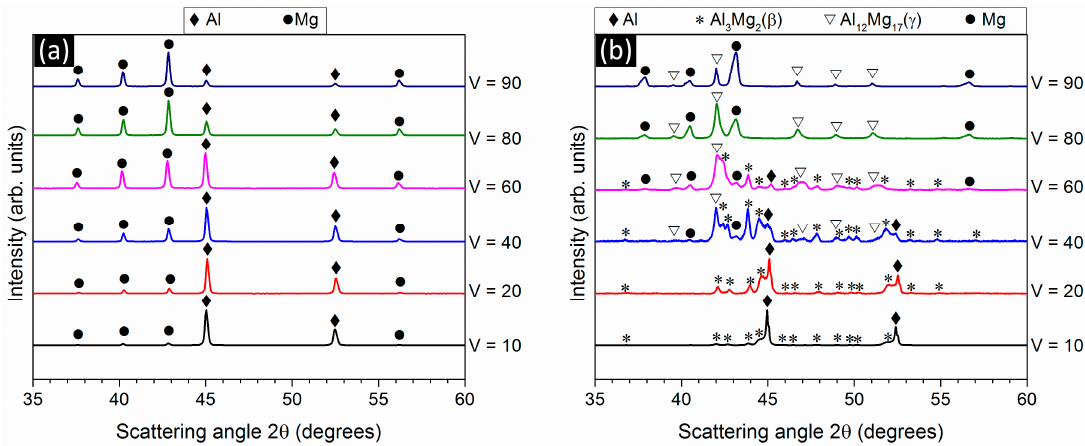
Figure 1. The X-ray diffraction (XRD) patterns (Co K α radiation) of Al-Mg ( a ) powder mixtures milled Figure 1. The X ‐ ray diffraction (XRD) patterns (Co K  radiation) of Al ‐ Mg ( a ) powder mixtures milled for 1 h and ( b ) composites hot-pressed at 673 K. ( V = 10, 20, 40, 60, 80, and 90 indicate the initial vol % for 1 h and ( b ) composites hot ‐ pressed at 673 K. ( V = 10, 20, 40, 60, 80, and 90 indicate the initial vol % of of Mg).